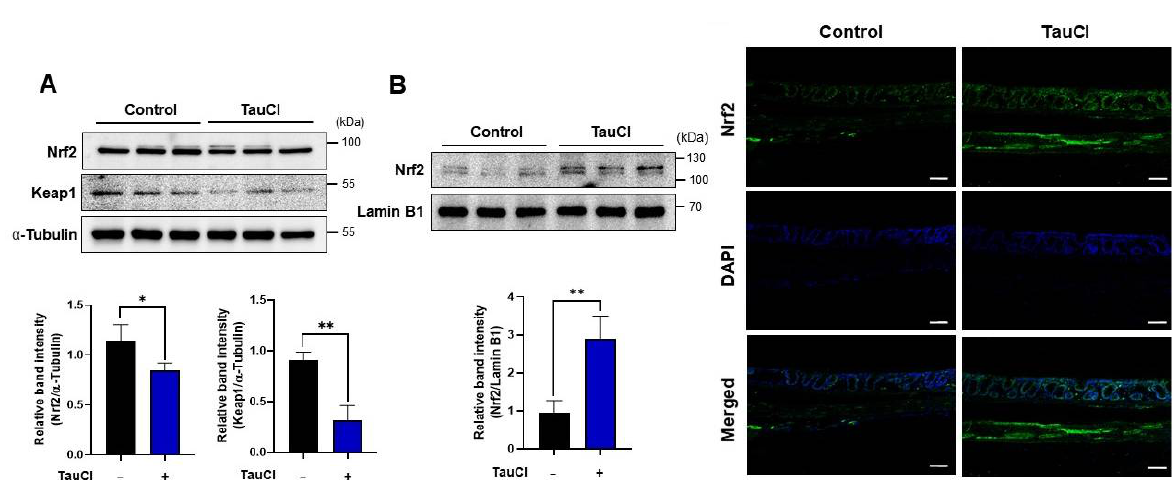
Figure 7. Induction of Keap1 degradation and nuclear translocation of Nrf2 by TauCl in mouse colon. Cytoplasmic levels of Nrf2 and Keap1 ( A ) and nuclear accumulation of Nrf2 ( B ) were measured by Western blot analysis. Nuclear localization of Nrf2 was verified by immunofluorescence staining ( C ). * , ** Significantly different between groups compared (* p < 0.05; ** p < 0.01). Scale bar, 200 μm.